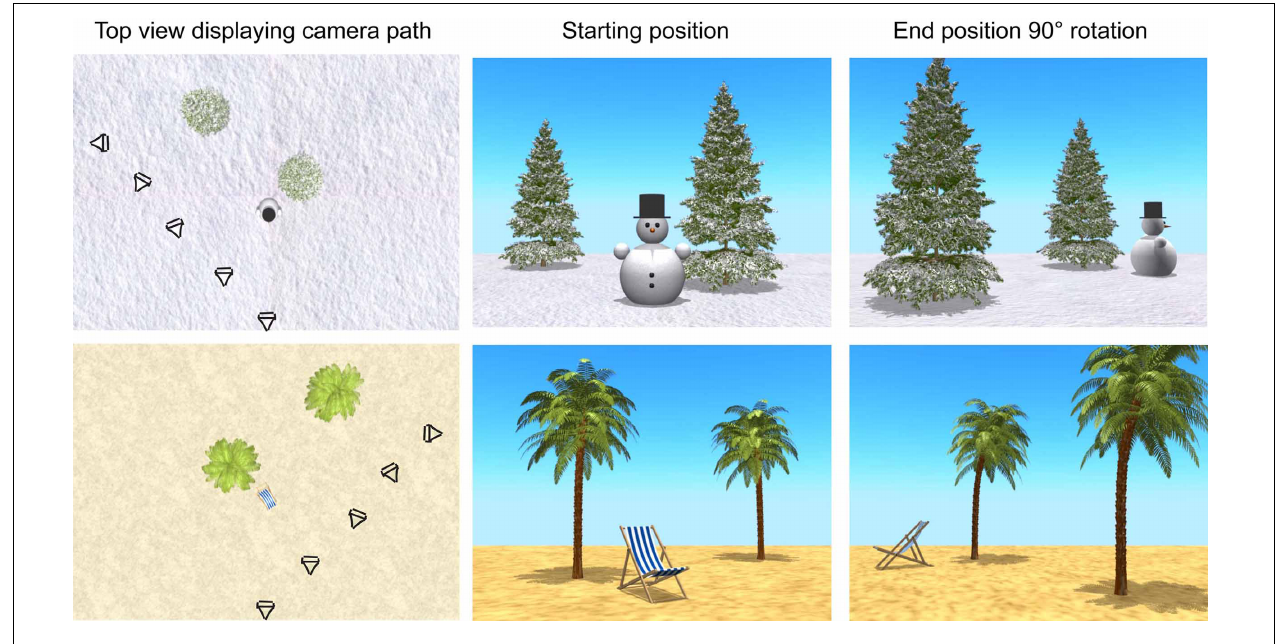
FIGURE 1 | Two virtual environments. Top view of two environments displaying camera paths with camera positions and angles at five time points, and screen shots of starting and end